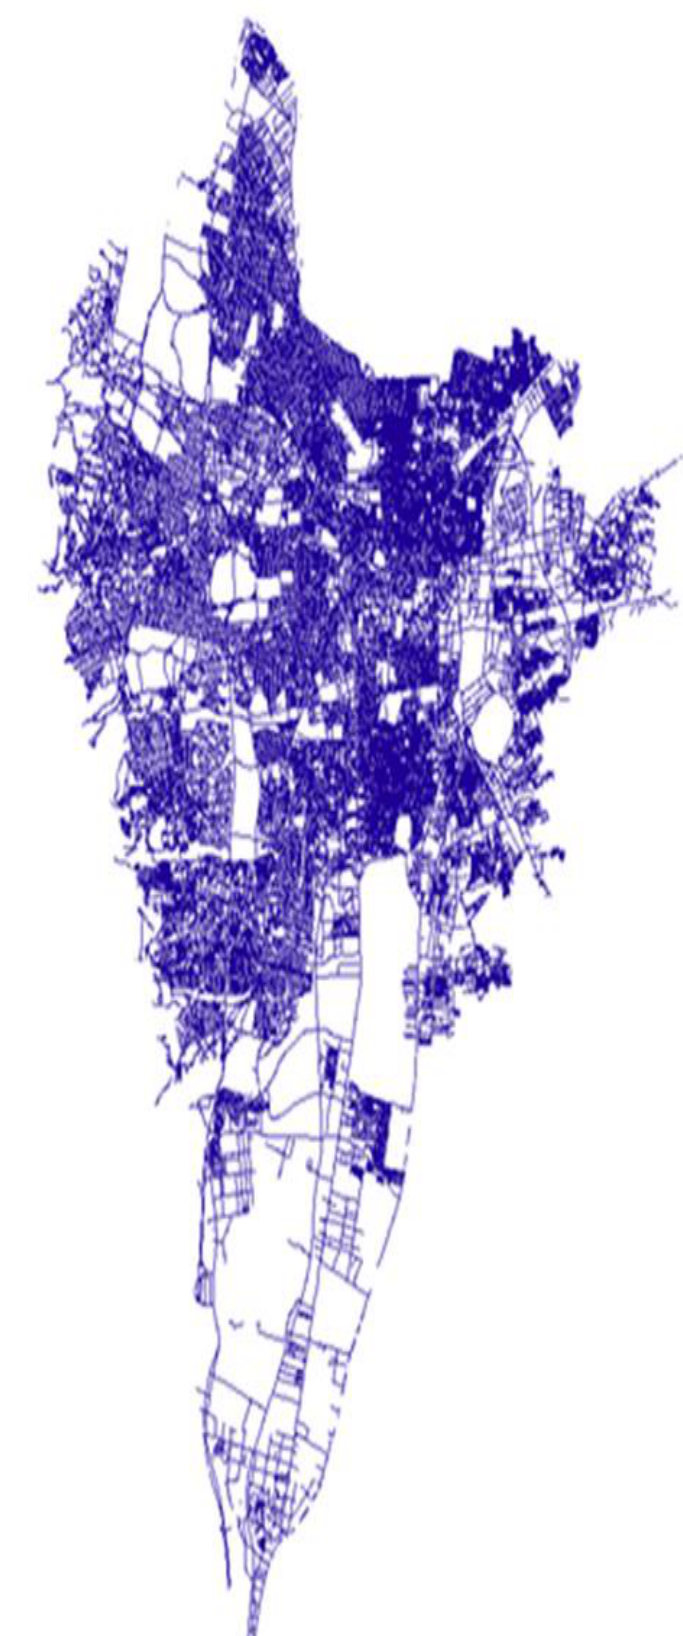
Figure 4: Reference Data of Tehran,